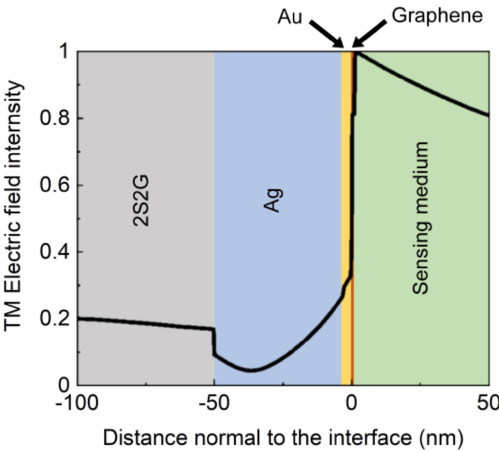
Figure 10. Normalized electric field intensity of the proposed SPR